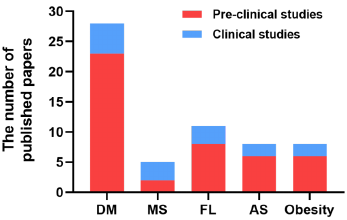
Figure 1. The number of papers published on the effects of H 2 on metabolic diseases. 2. Protective Effects of H 2 against Metabolic Diseases 2.1. Diabetes Mellitus